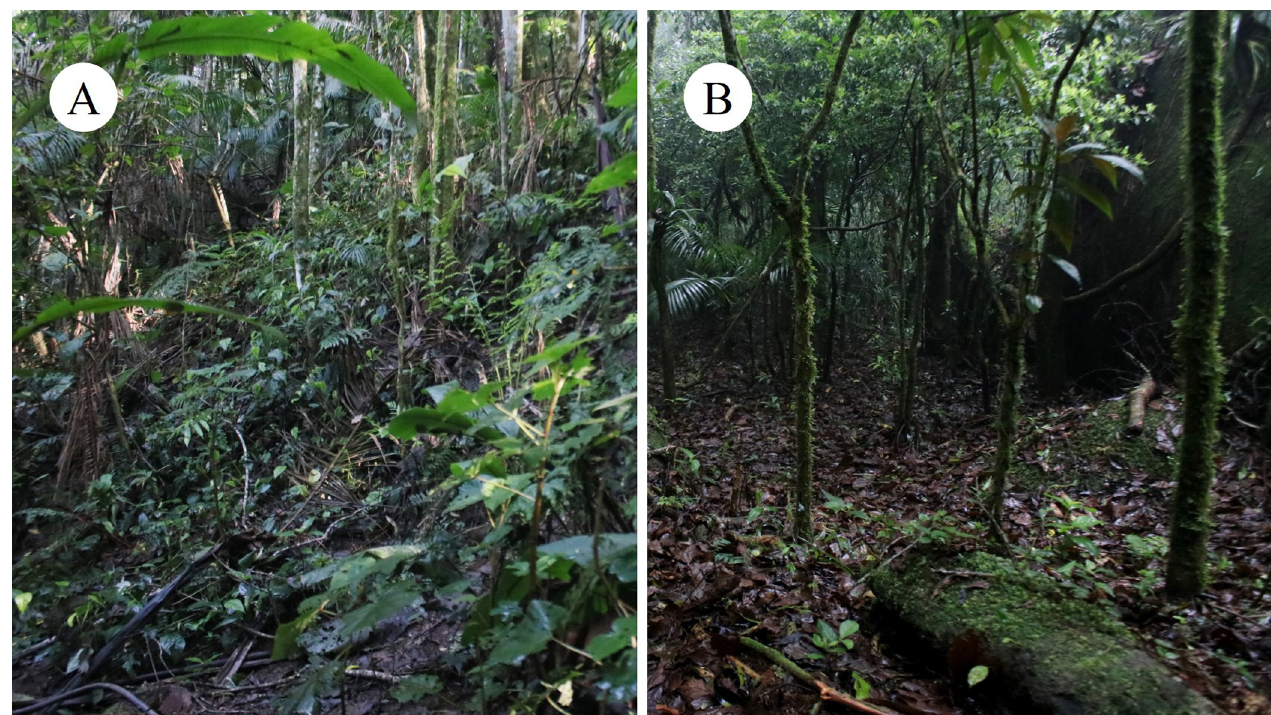
Fig 8. Study areas for the natural history observations of Brachycephalus rotenbergae sp. nov. (A) S ã o Francisco Xavier, Projeto Dacnis, and (B) Reserva das Arauca´rias.